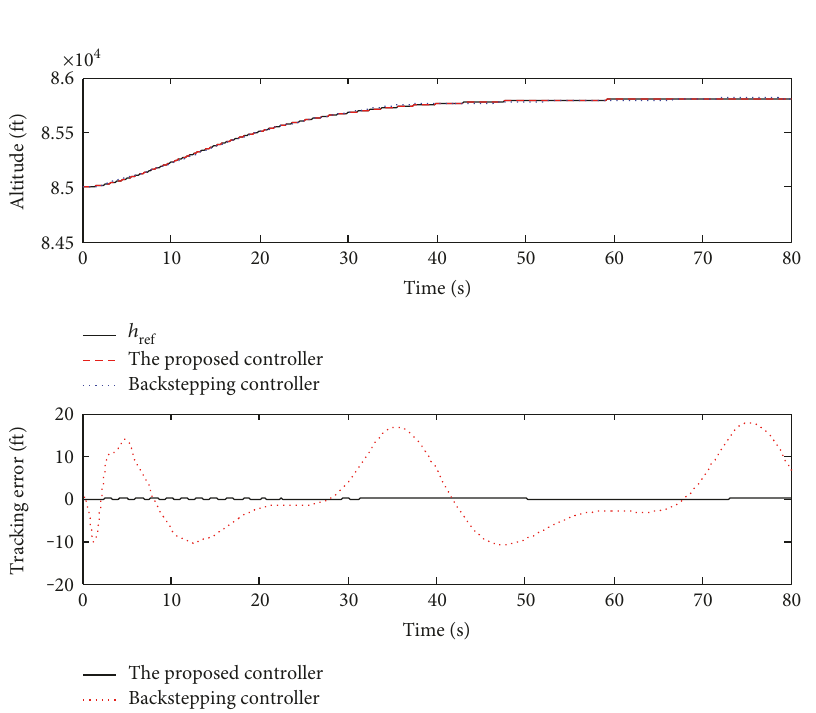
Figure 3: Altitude tracking